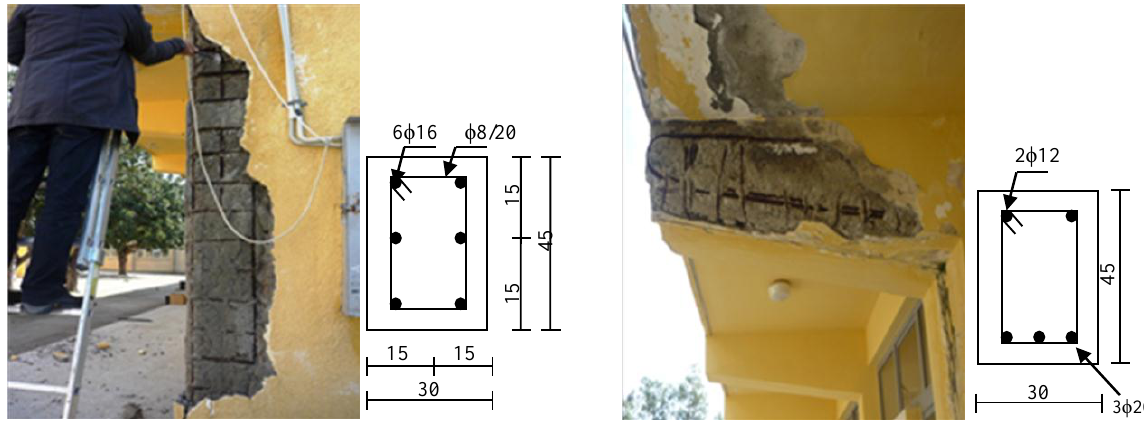
Fig. 3. Outface of S 1 column. Fig. 4. Volume expansion of corrosion